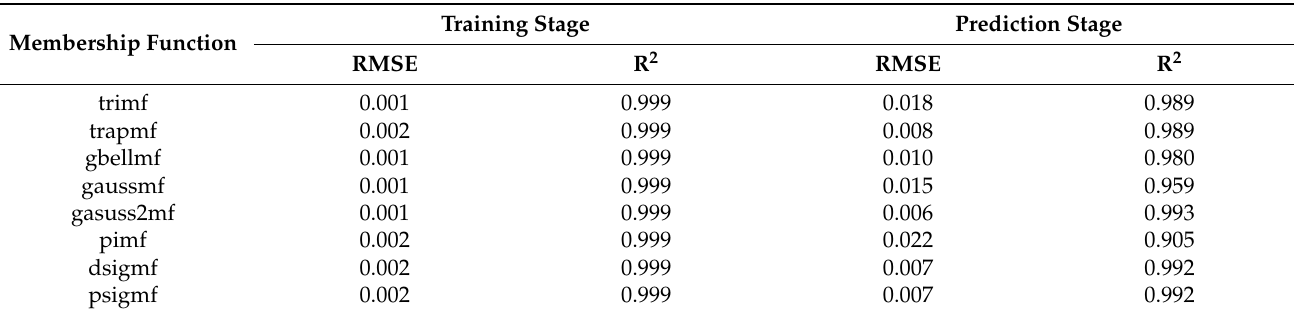
Table 1. Root-mean-square error (RMSE) and determination coefficient (R 2 ) for the prediction of chlorophyll content in the pericarp by the adaptive neural fuzzy inference system (ANFIS) model with different input membership functions (MFs) in the training and prediction